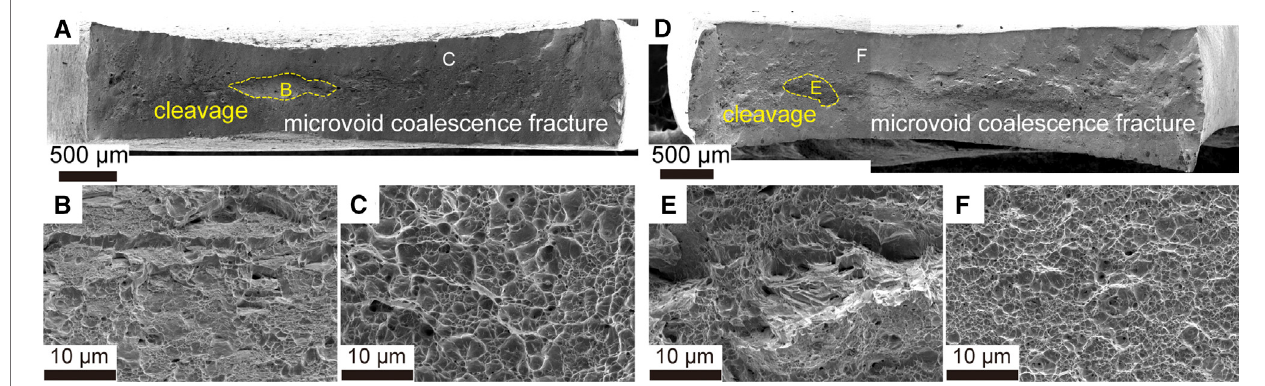
Frontiers in Materials |